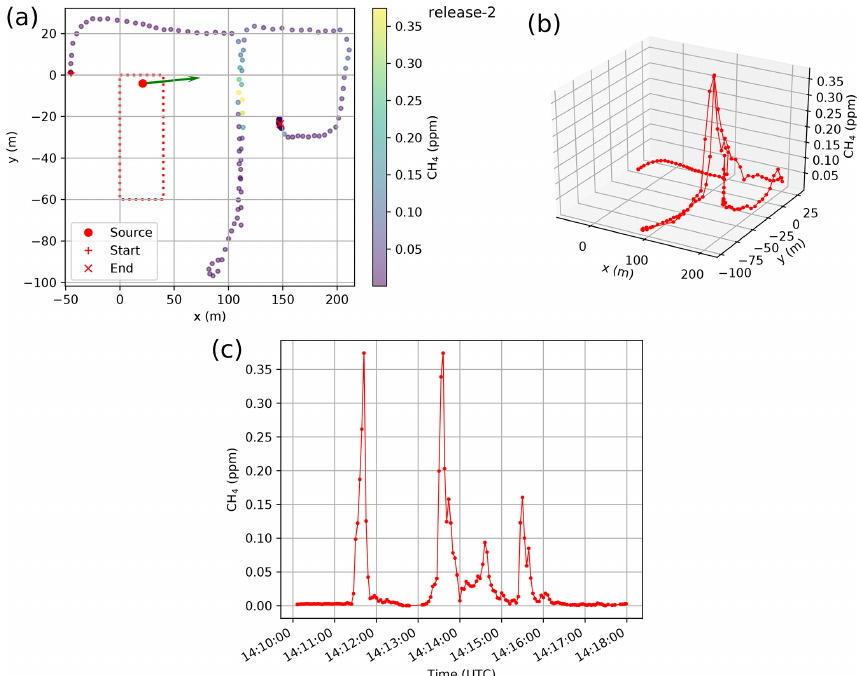
Figure 2. Mobile CH 4 mole fraction measurements during CH 4 release no. 2 (Table 2): (a) horizontal representation, (b) 3D representation with values as a function of the horizontal location, and (c) time series. The green arrow from the source location in (a) shows the averaged wind direction during that